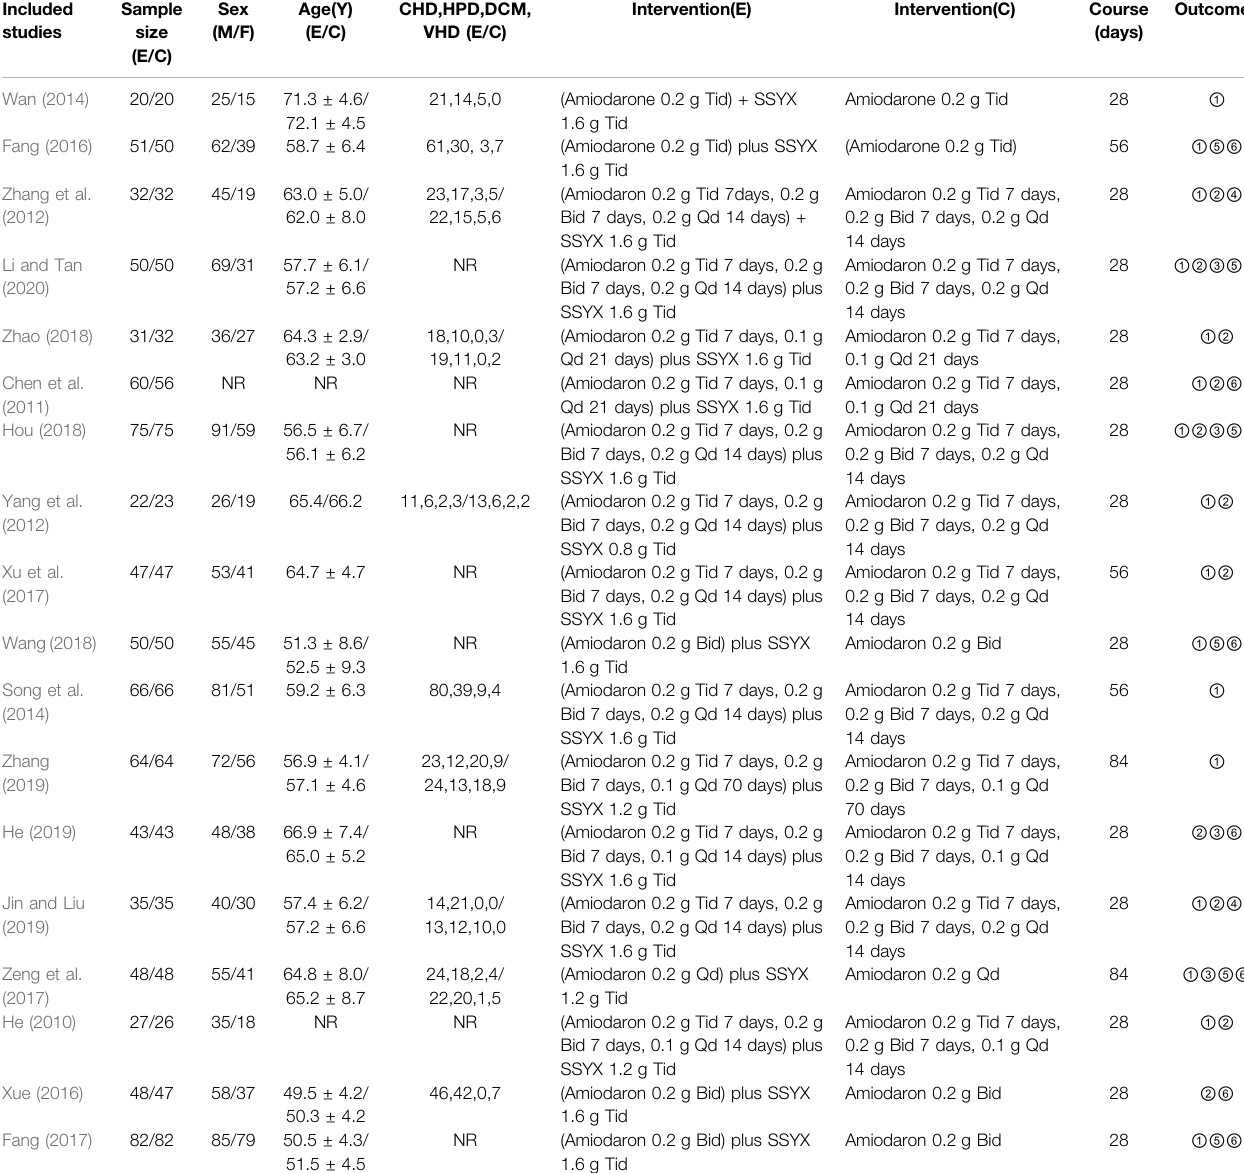
TABLE 2 | Characteristics of the included